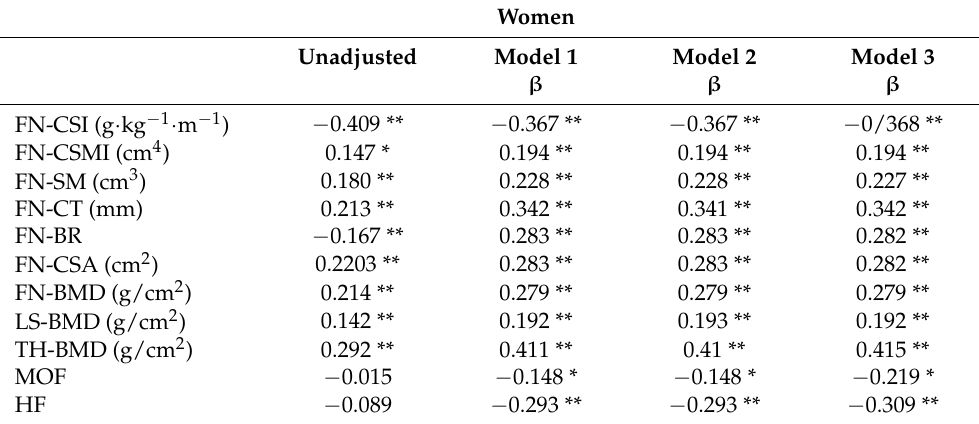
Table 4. Linear regression analysis between the TyG-BMI and the densitometry parameters.